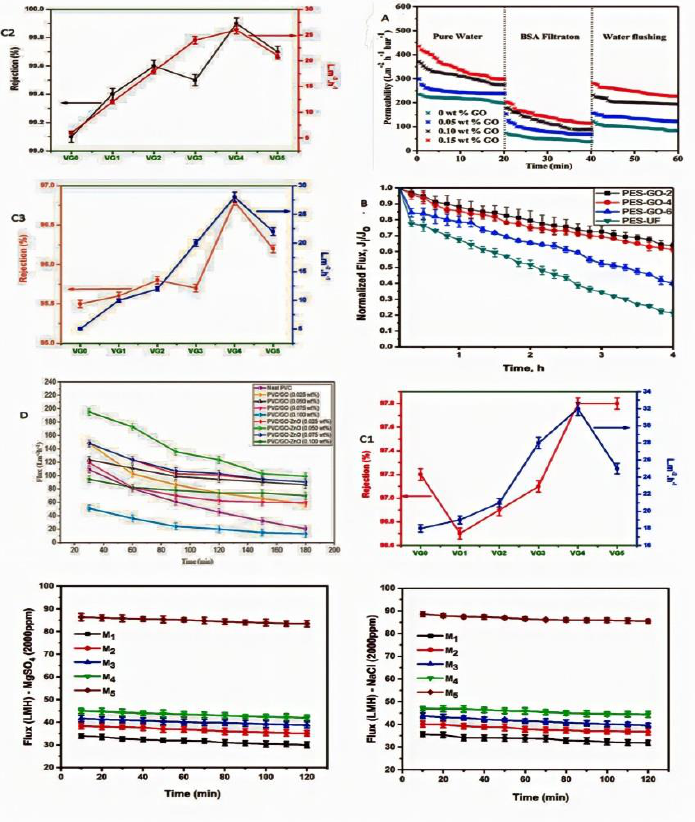
Figure 10. Perm − selectivity of different polymers mixed with GO. ( A ) PVC/GO membranes filtration of BSA solution [129]. ( B ) PES/GO membranes humic acid filtration [98]. ( C ) PVA/VTES − G membrane for dyes: ( C1 ) Congo Red, ( C2 ) Reactive Black 5 and ( C3 ) Reactive Orange 16 [133]. ( D ) PVC/GO − ZnO membrane filtration of oily wastewater [106]. ( E ) PSf/GO − vanillin membranes filtration (NaCl) and (MgSO 4 ) [109].